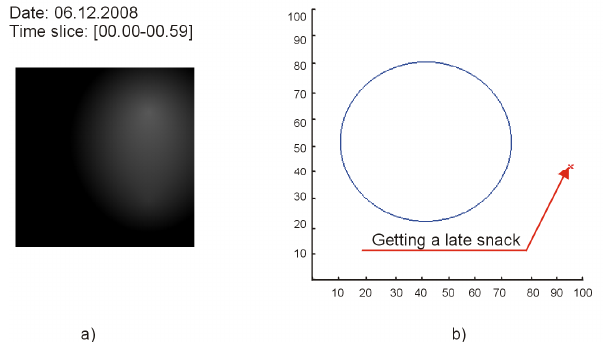
Figure 11. Kasteren House C dataset: An illustration of how the system identified the time slice [00.00 am–00.59 am] from 6 December 2008, as an unusual moment for a snack. ( a ) the activity map for the respective time slice ( b ) plot of the centroid of the activity map vs. the SBC of the centroids for the corresponding time slices of the reference interval.